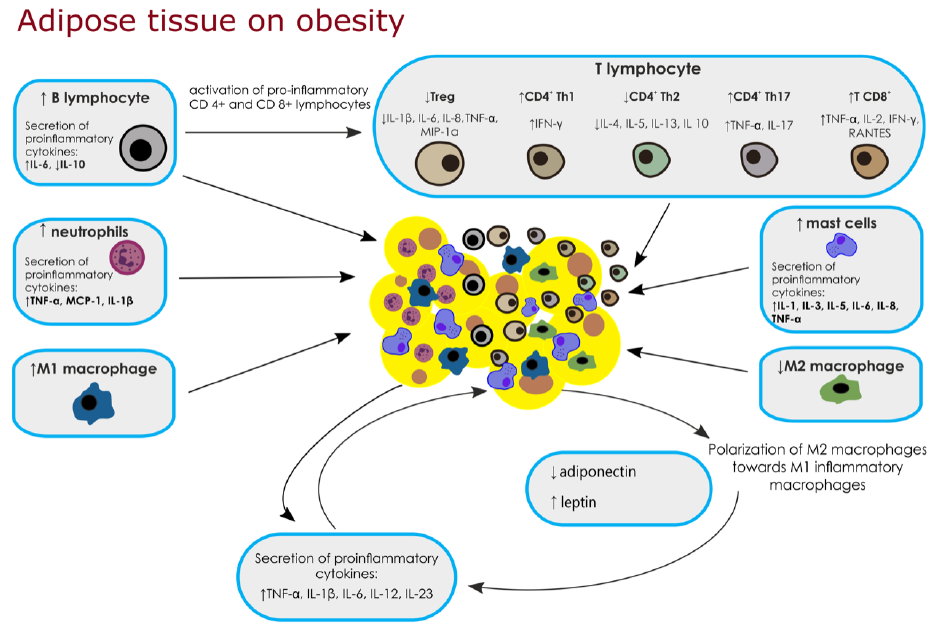
Figure 1. Diagram showing biological factors in adipose tissue in obesity. Description in the text. Abbreviations: ↑ - in- crease, ↓ - decrease, TNF- α (tumor necrosis factor- α ); IL-1 β (Interleukin-1 β ); IL-6 (Interleukin-6); IL-12 (Interleukin-12); IL-23 (Interleukin-23); iNOS (induced nitric oxide synthase); NO (nitric oxide); IL-10 (Interleukin-10); MCP-1 (Monocyte Chemoattractant Protein-1); IL-1 (Interleukin-1); IL-3 (Interleukin-3); IL-5 (Interleukin-5); IL-8 (Interleukin-8); Treg (reg- ulatory T cells); MIP-1 α (macrophage inflammatory protein-1 α ); Th1 (T-helper-type 1); IFN- γ (Interferon- γ ); Th2 (T-helper-type 2); IL-4(Interleukin-4); IL-13(Interleukin-13); Th17 (T-helper-type 17); IL-17 (Interleukin-17); IL-2(Interleukin-2); plasminogen activator inhibitor-1 (PAI-1).